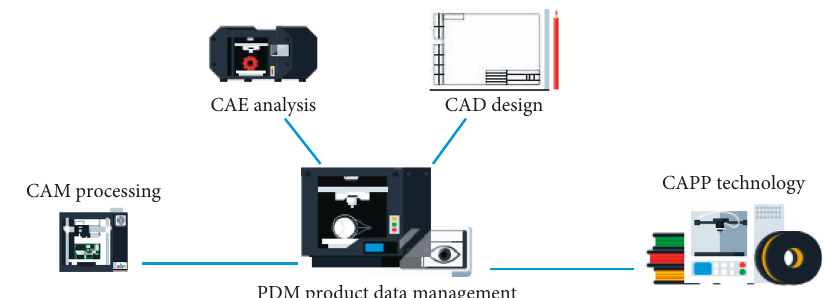
Figure 1: Typical case of CAD/CAM platform design and